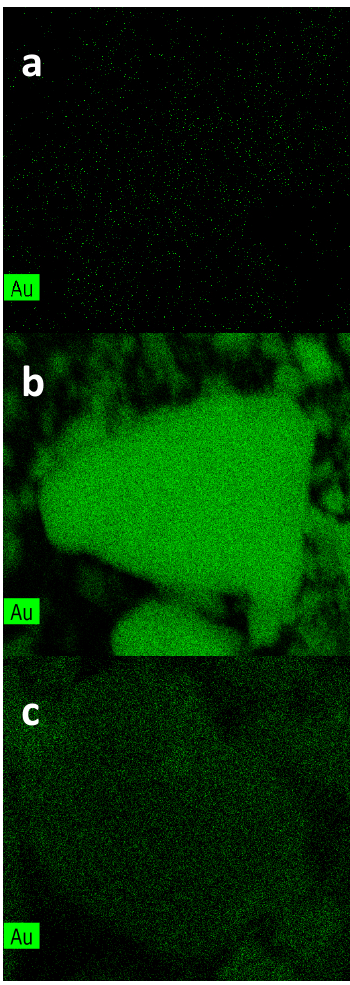
Figure 4. EDX elemental mapping of samples ACePVA (section a ), AuZrPVA (section b ) and ATiPVA (section c ).